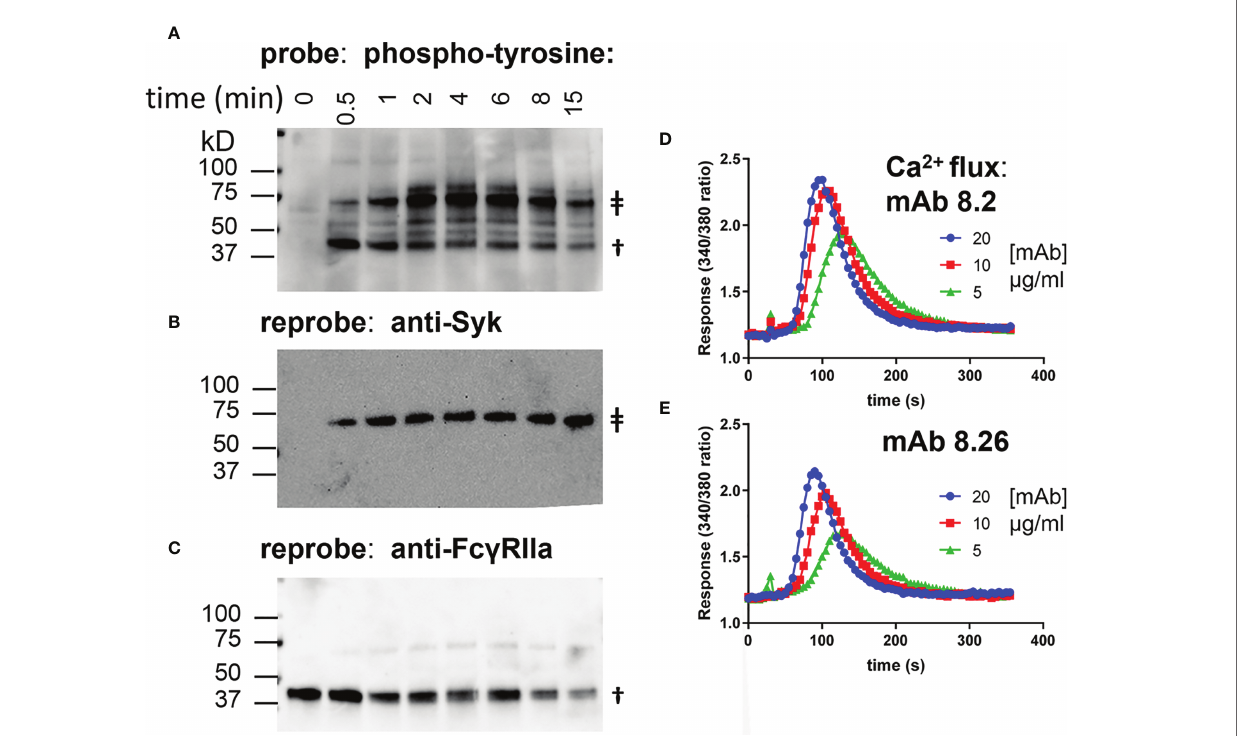
FIGURE 1 | mAb 8.2 stimulates tyrosine phosphorylation of Fc g RIIa-WT and mAb 8.2 and mAb 8.26 stimulate cell Ca 2+ fl ux. (A – C) Western blots of proteins captured by the plate-bound anti-Fc g RIIa mAb 8.7 from lysates of mAb 8.2 activated Fc g RIIa-WT cells. Detection was, (A) phosphotyrosine, (B) Syk and (C) Fc g RIIa. The symbol ‡ indicates syk at 72 kD and † indicates Fc g RIIa at ~40 kD. (D, E) calcium mobilisation by IIA1.6 Fc g RIIa-WT (H131) cells loaded with Fura-2 and treated with mAbs 8.2 and 8.26 as